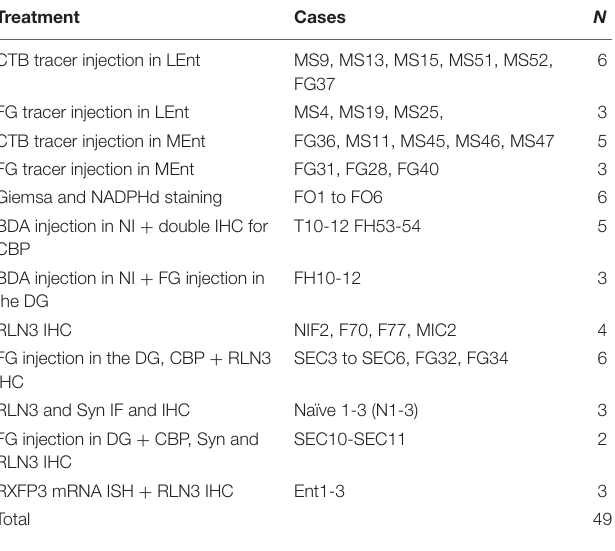
TABLE 1 | Summary of the cases (rats) used in the present